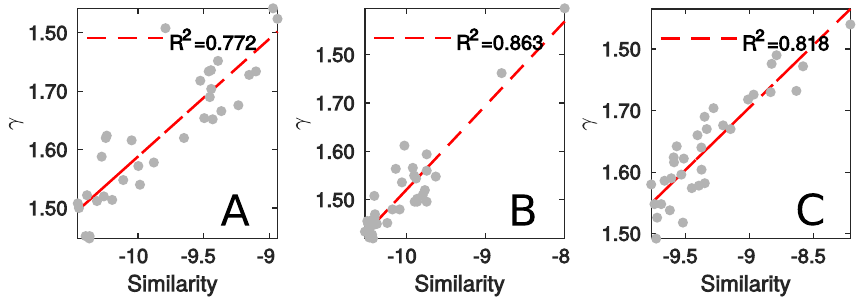
Figure 5. Comparison between the calibrated parameter γ t and trip similarity index for ( A ) Guangzhou, ( B ) Shanghai and ( C ) Shenzhen.